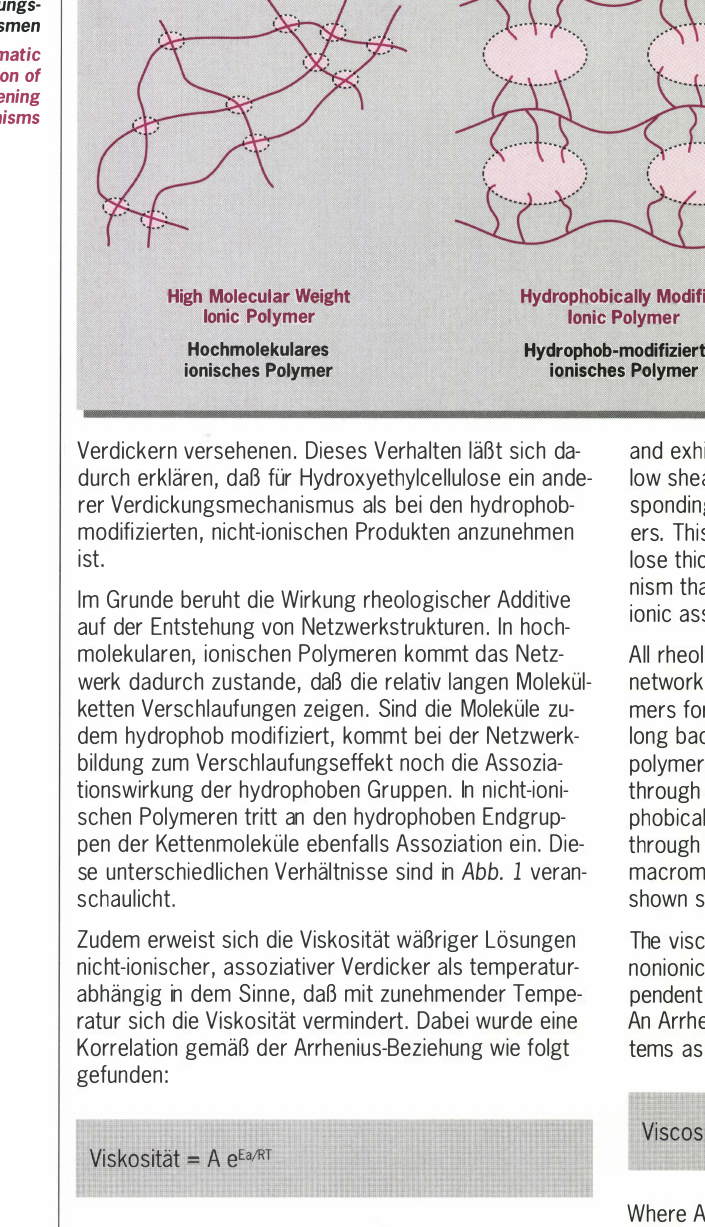
Fig. 1: Schematic presentation of thickening mechanisms